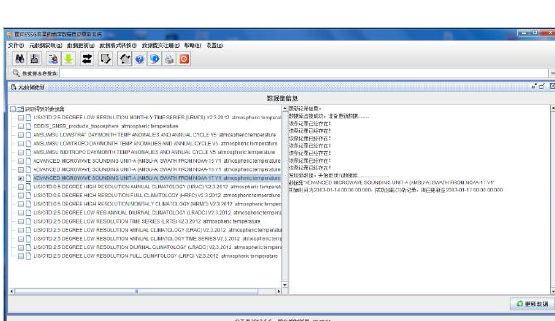
Fig.9 Updating of the dataset 'ADVANCED MICROWAVE SOUNDING UN17-A (AMSU-A) SWATH FROM NOAA- 17' into V-Pools automatically in the spatial reference of